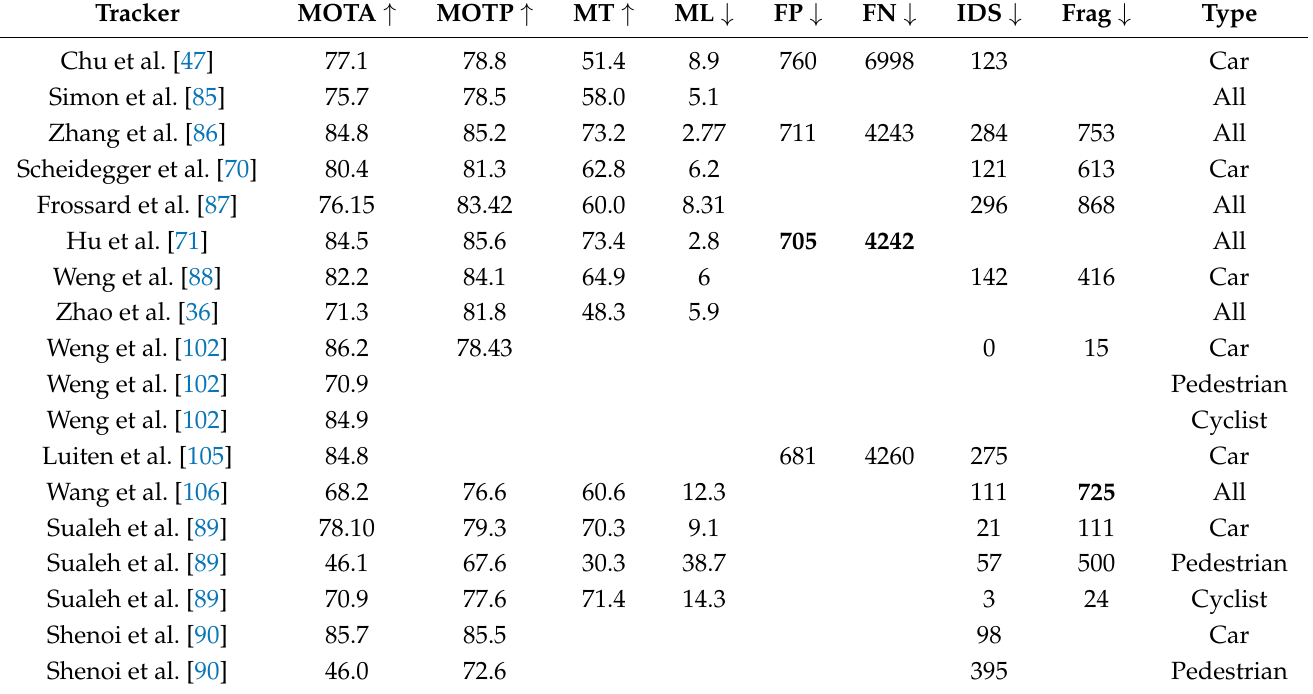
Table 6. The performance using the KITTI dataset. We have marked the highest scores in bold for methods evaluated on all